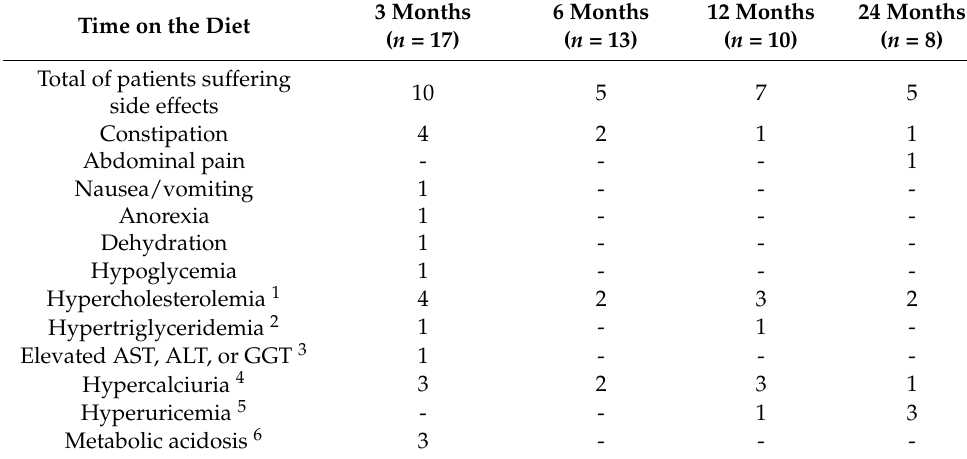
Table 2. Long-term side effects in patients on a ketogenic dietary therapy. Time on the